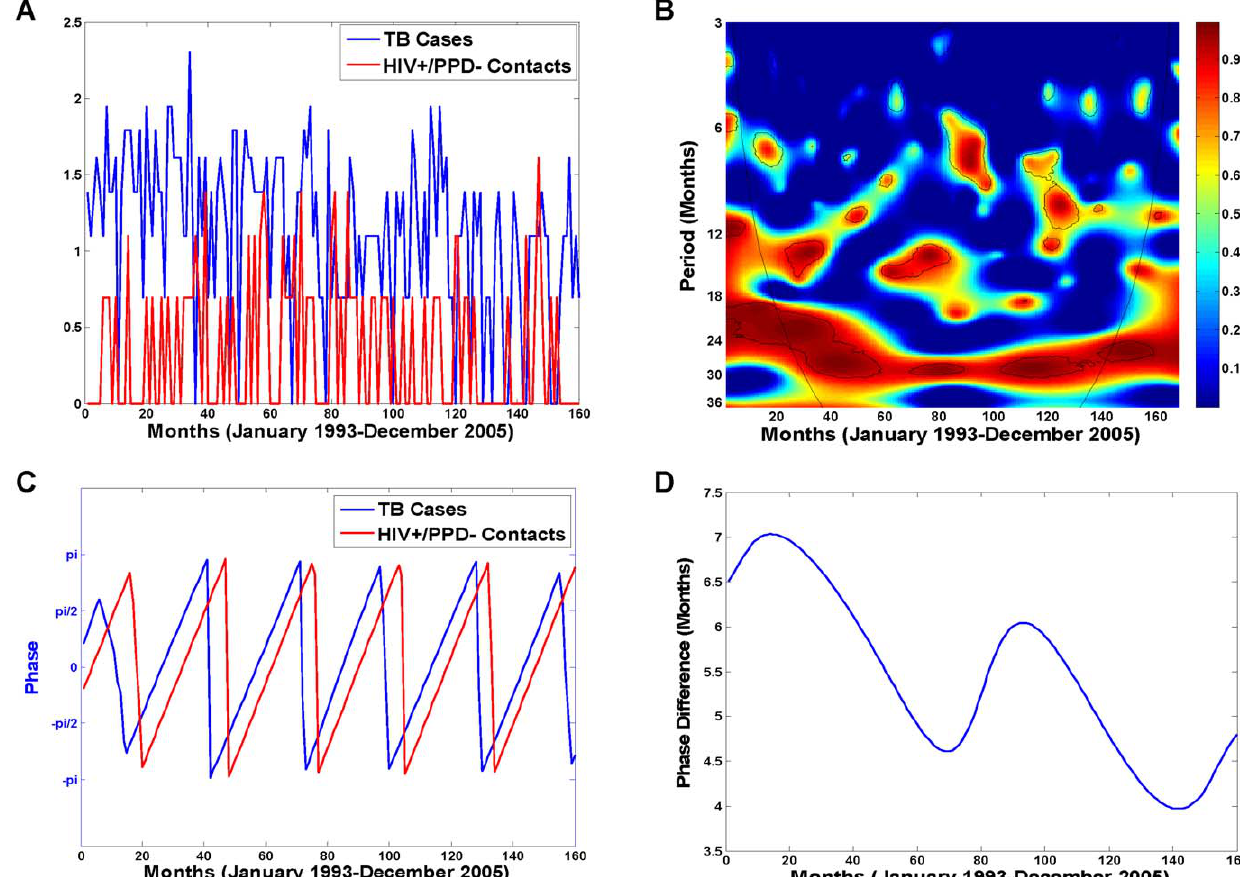
Figure 4. Wavelet time series analysis of the homeless TB cases and their HIV + /PPD 2 contacts, January 1993–December 2005. Both time series were log-transformed and standardized (mean centered with unit variance) before wavelet analyses were performed. (A) Log-transformed time series of the TB cases and their HIV + /PPD 2 contacts. (B) Wavelet coherence between the homeless TB cases and their HIV + /PPD 2 contacts. One periodic component at 27–31 months is present at a ~ 5% significant level (black lines), computed based on 400 bootstrapped series. The colors code for power values from dark blue, representing low values, to dark red, representing high values; the superimposed parabola is the cone of influence, which measures the extent of edge effects. (C) Wavelet phase evolution of homeless TB cases and their HIV + /PPD 2 contacts computed at the at the 27–31 months periodic band in radians. (D) Wavelet phase difference of the phases of TB cases and their HIV + /PPD 2 contacts computed at the 27–31 months periodic band. Waves of TB cases and their HIV + /PPD 2 contacts are separated, with a mean lag time of 5.4 months over the entire 13-year period, and with a mean lag time of 4.4 months over the four-year period from January 2002 to December 2005, when the HIV related data is most